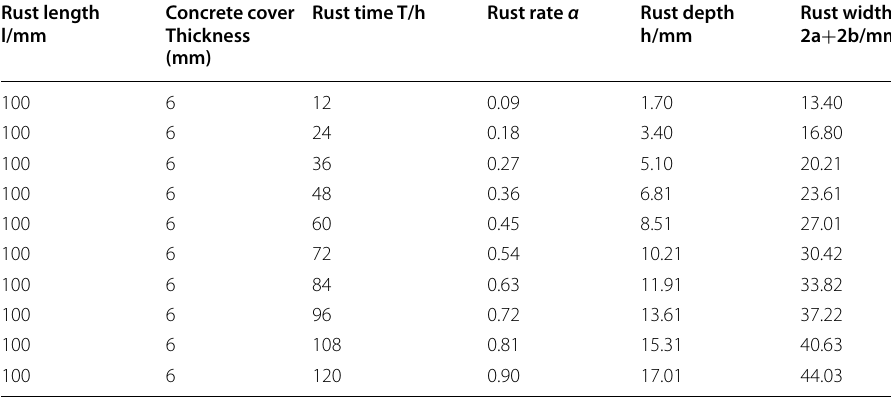
Table 5 12-mm steel bar diameter model parameter settings (mm) Rust length l/mm